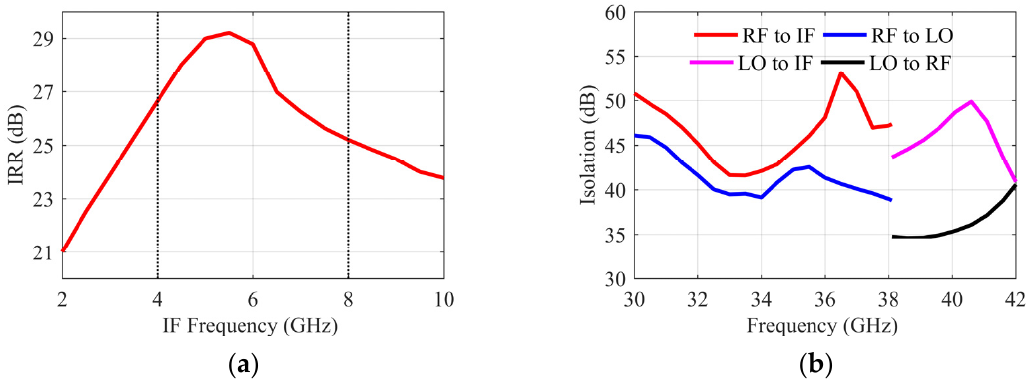
Figure 9. ( a ) Simulation result of IRR. ( b ) Simulation results of isolation between each port.